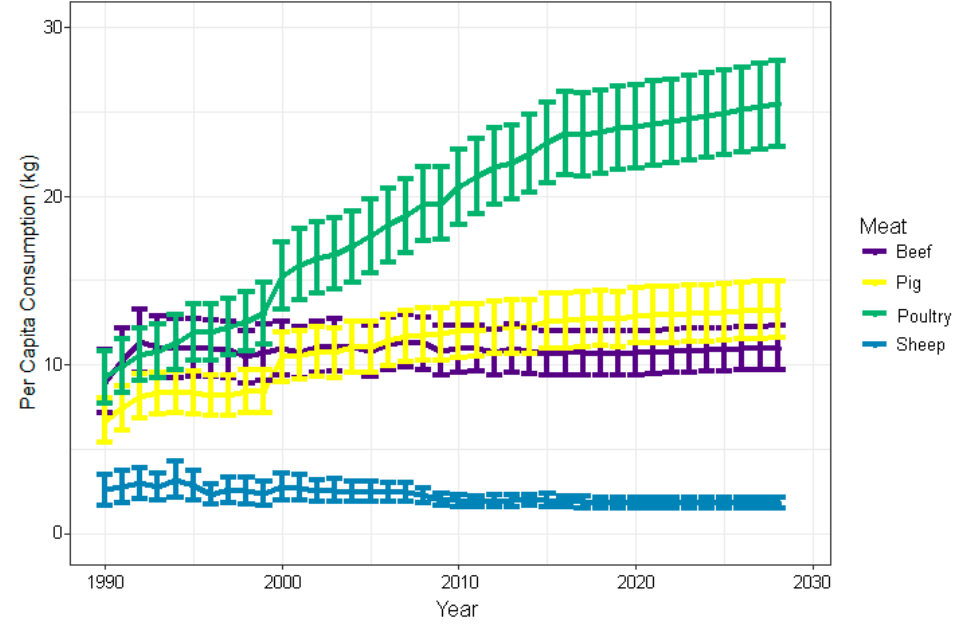
Figure 3. Predicted trends 1990 – 2028 in global livestock meat per capita (kg) consumption. Data summarized from OECD meat consumption [32].